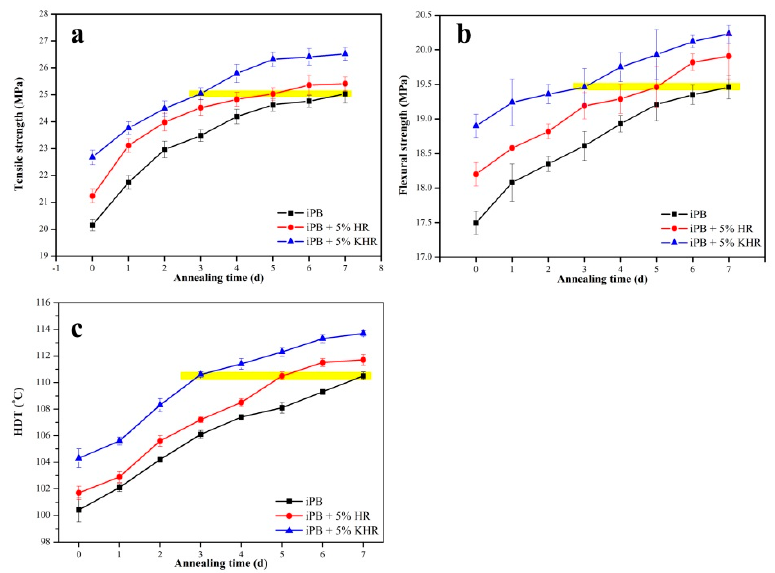
Figure 8. The physical properties of the iPB/HR composite (( a ). Tensile strength; ( b ). Flexural strength; ( c ). HDT).